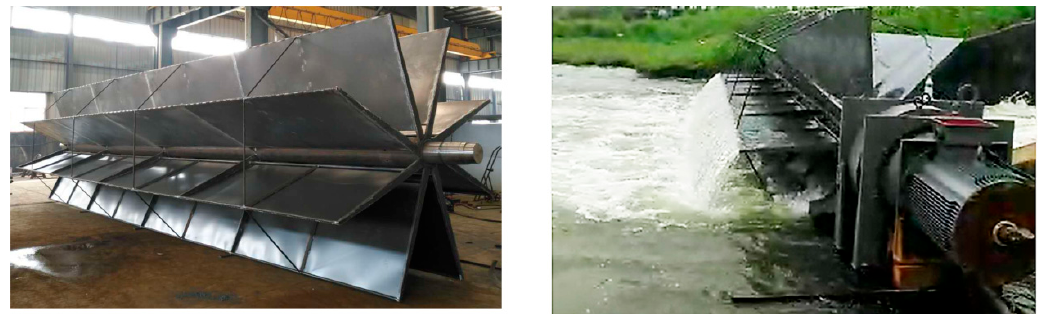
Figure 4. Test devices.